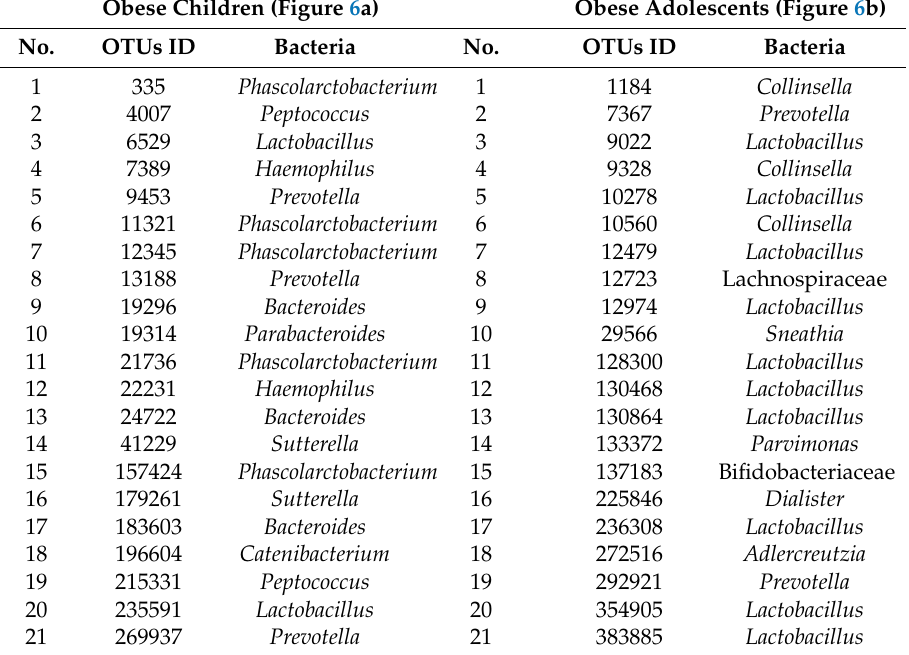
Figure 6. Significant co-occurrence analysis between gut microbiota in obese Mexican children ( a ) and adolescents ( b ). This graphic shows selected interactions between different bacterial communities; copresence (positive, green lines) and mutual exclusion (negative, red lines). This analysis was performed using otu_table.biom file in CoNet plugin tool and generated co-occurrence networks were visualized by Cytoscape (v3.6.1) software as described in Material and Methods. Each node indicates a microbial clade (bacterial taxon) belonging to a unique OTUs number. Edges (lines) connecting two nodes, represent significant correlations ( p < 0.05; q < 0.05; R > 0.8). In this graphics some bacteria names are shown more than one time e.g., Lactobacillus, Prevotella, etc., however they belong to different OTUs number. Bacteria names and corresponding OTU number are shown in Table 3, while a complete set of networks in Figure S3 and S4, and their corresponding OTU number are shown in Table S10, S11, and the significant interaction values are shown in Table S12. Table 3. List of bacterial taxa with their operational taxonomic unit (OTU) IDs for Figure 6. Obese Children (Figure 6a) Obese Adolescents (Figure 6b)